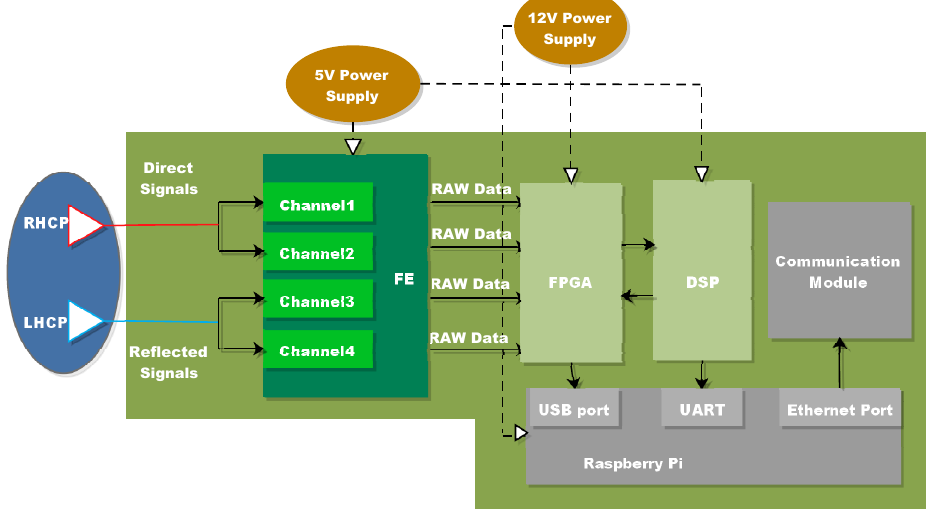
Figure 2. Hardware scheme of the sensor. Table 1. Parameters of the LHCP antenna used in this